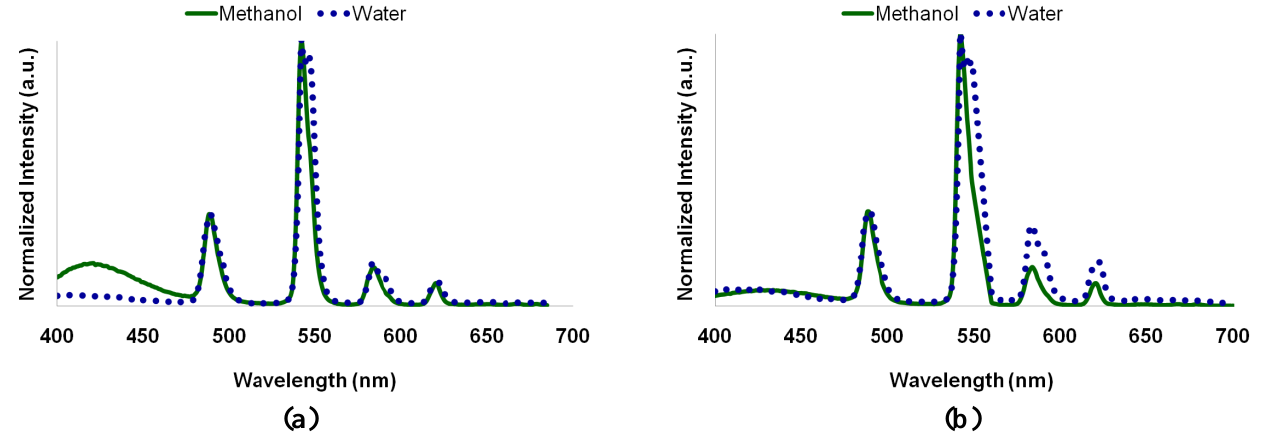
Figure 5. (a) Photoluminescence spectra under direct ion excitation at 350 nm of PMMA:ASA:Tb 3+ :LaF nanocomposite; (b) Photoluminescence spectra under direct 3